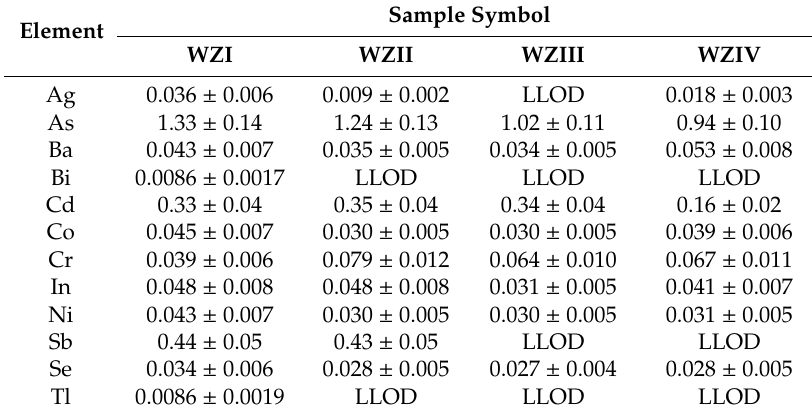
Table 2. Trace elements content of the investigated samples WZI, WZII, WZIII and WZIV (in wt %).